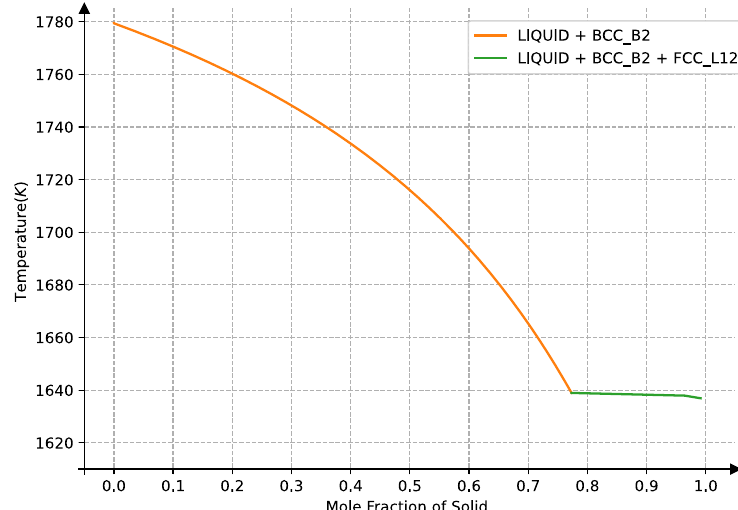
Figure 10. The solidification of an equal-atomic AlCoFeNi alloy.